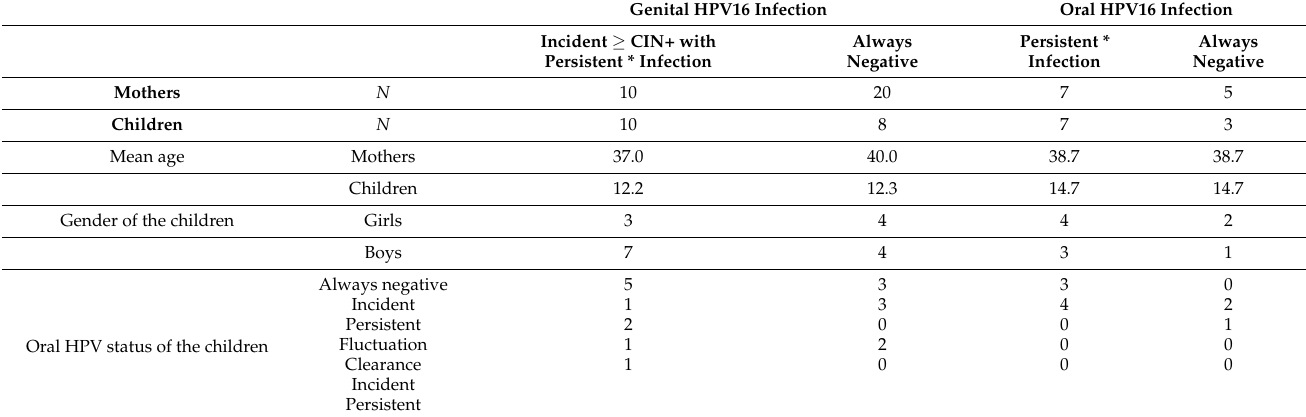
Table 2. Baseline characteristics of the subgroups of mothers ( n = 42) and their children ( n = 28) from the Finnish Family HPV